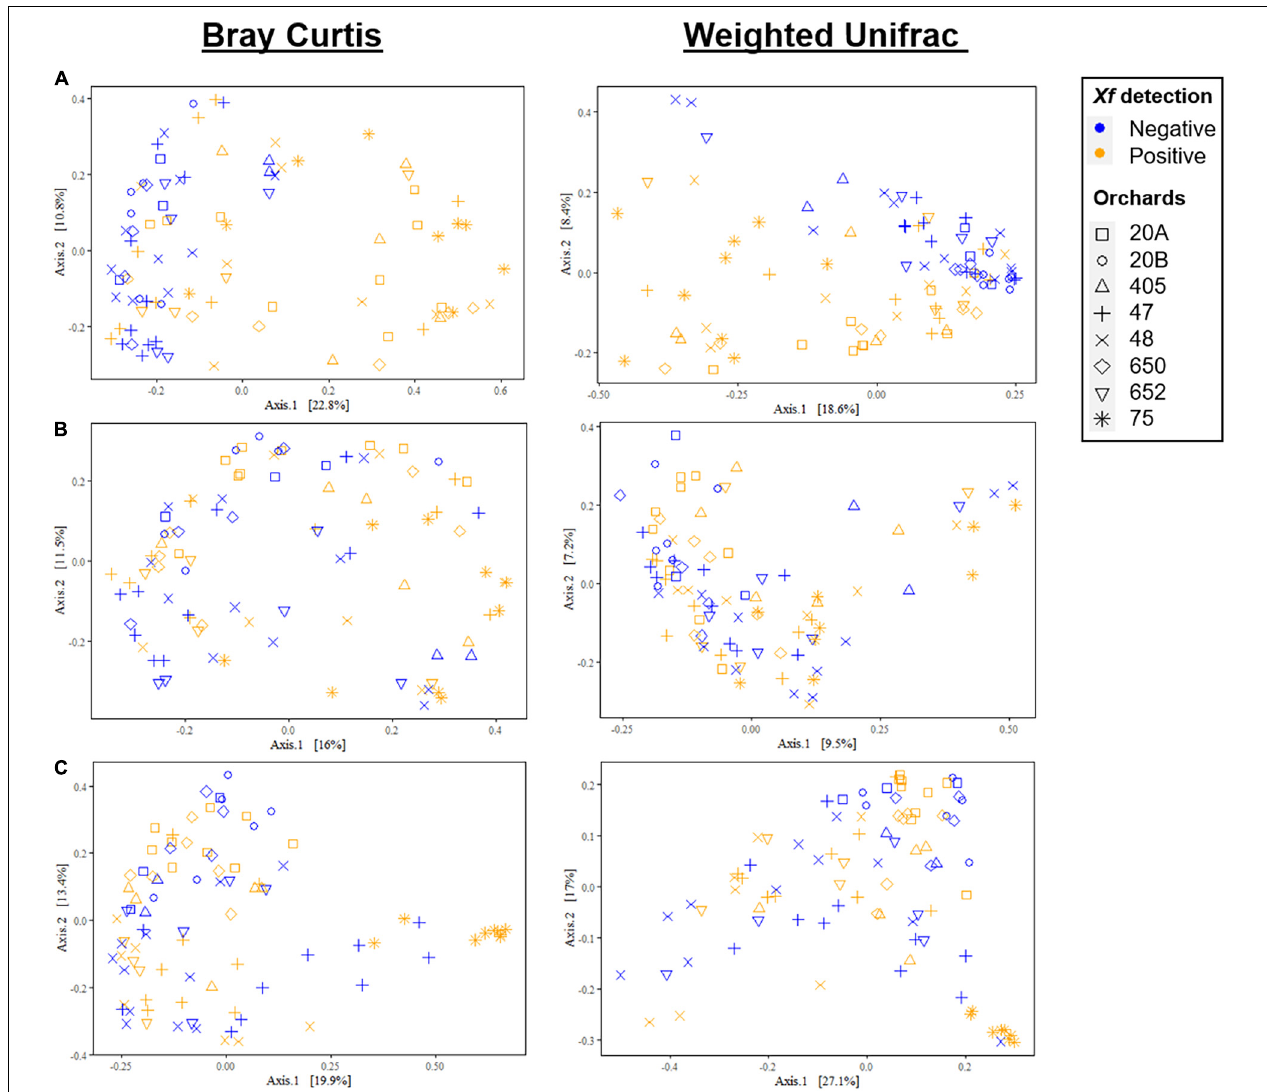
FIGURE 3 | Principal coordinate plots of Bray–Curtis and weighted UniFrac distances of bacterial (A,B) and fungal communities (C) at the ASV taxonomic level in the xylem of Xylella fastidiosa -qPCR negative and positive almond trees sampled in different orchards in Alicante province. X. fastidiosa ASVs were maintained (A) or removed (B) from the data set before analysis. Points are colored by X. fastidiosa detection and shaped by